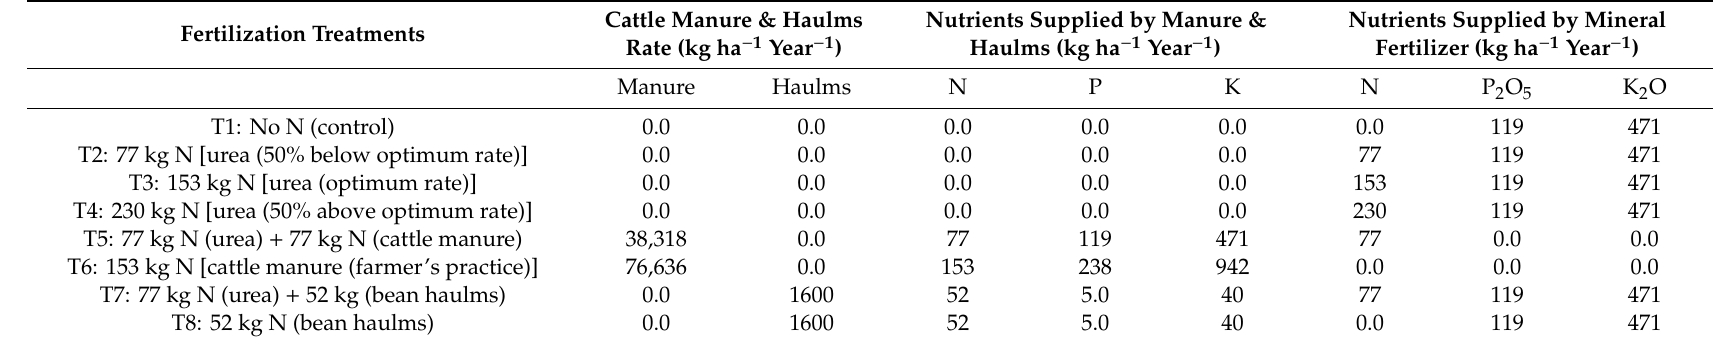
Table 2. Fertilization treatments, nutrient sources and application rates.